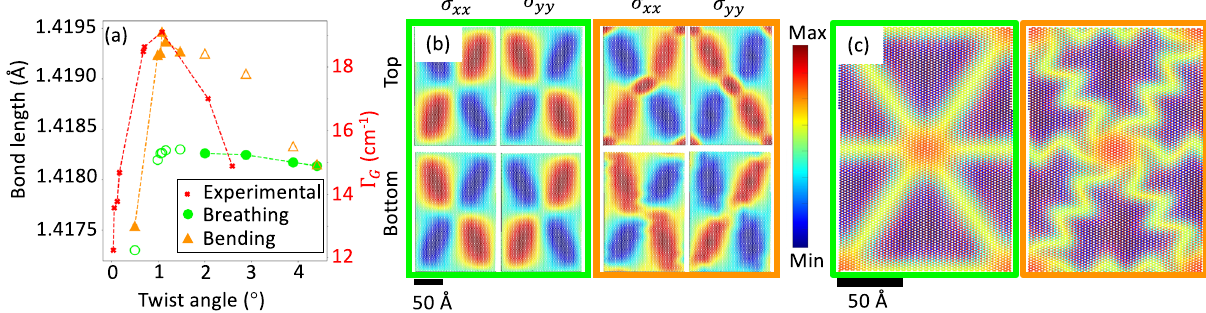
Fig. 3 Stress and energy distribution of magic-angle twisted bilayer graphene (tBLG). a Interatomic bond length and micro-Raman Γ G peak as a function of twist angles. The Γ G peak is shifted to the scale of bond length. The fi lled markers indicate the twist angles where each mode is stable. The dashed line is a guide for the data of the Γ G peak and bond length for the stable modes. The maximum bond length for the breathing mode occurs at 1.47 ∘ but shifts to 1.08 ∘ for the bending mode. Similarly, the full wave half-maximum Γ G peak occurs at 1.08 ∘ . The micro-Raman experimental data are taken from the literature 40 . b Stress components ( σ xx and σ yy ) for top and bottom layer of magic-angle tBLG in the breathing and the bending mode. The bending modes has a reduced symmetry relative to the breathing mode. c Total energy distribution of the magic-angle tBLG to demonstrate the distinctive dislocation behavior between breathing and bending mode. While the SP regions form straight dislocations connecting the AA regions in breathing mode tBLG, the SP regions in bending mode tBLG are kinked, forming wave-like